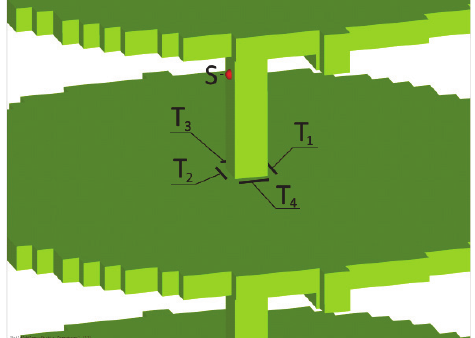
Figure 6: Location of cracks at the bottom of the column.